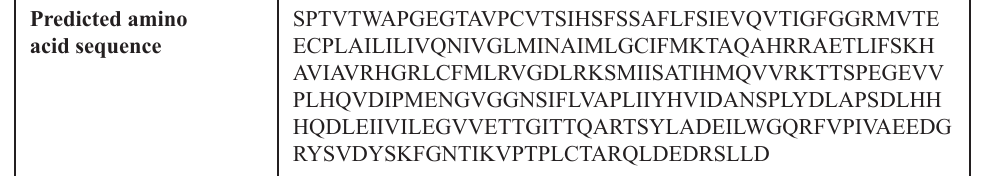
Figure 2. Phylogenetic analysis of nucleotide sequence of exon region of KCNJ11 gene Predicted amino acid